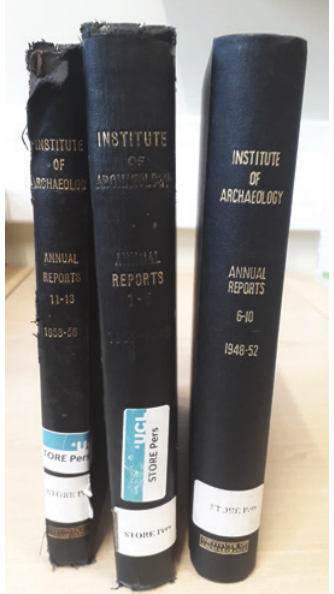
Figure 1 UCL Library Services’ print volumes of the Annual Report of the Institute of Archaeology reveal the wear and tear of frequent use (Source: photograph by Katie